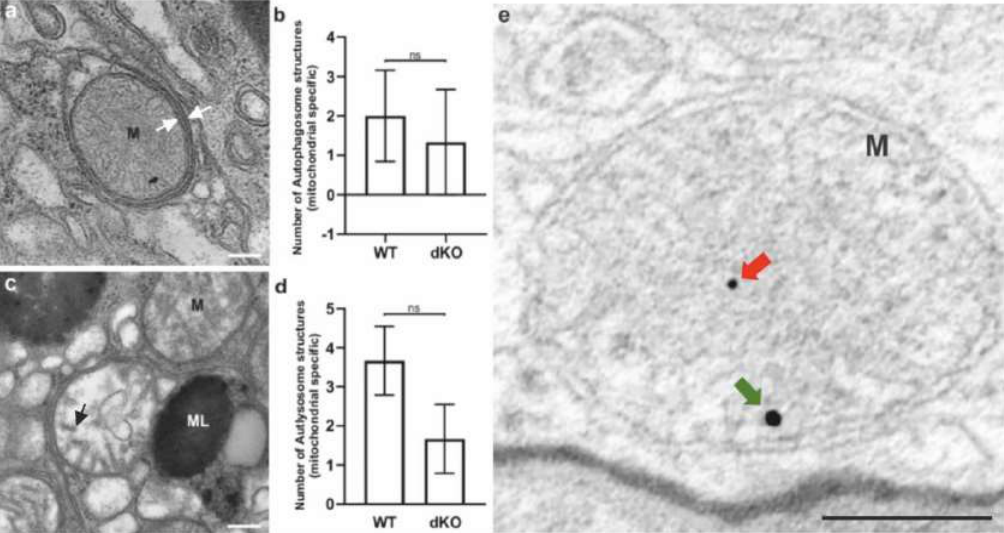
Figure 7. Representative TEM pictures of autophagosome and autolysosome of selective autophagy, i.e., mitophagy. Mitochondria (M) fully enveloped within an autophagosome ( a ). The white arrows indicate the double membrane of matured autophagosome. The amount of mitochondria-specific early autophagosomes between WT and dKO was statistically ( b ) nonsignificant (ns). Highly degraded mitochondria, representing a late autolysosome (the black arrow shows degrading cristae) ( c ). No statistical significance was found in the number of the late autolysosome structures between WT and dKO ( d ). The red and green arrows indicate PINK and PARKIN immunogold particles in the dKO RPE samples, respectively ( e ). ML, melanosome. Scale = 0.5 µ m (a and c), scale = 0.2 µ m (e).